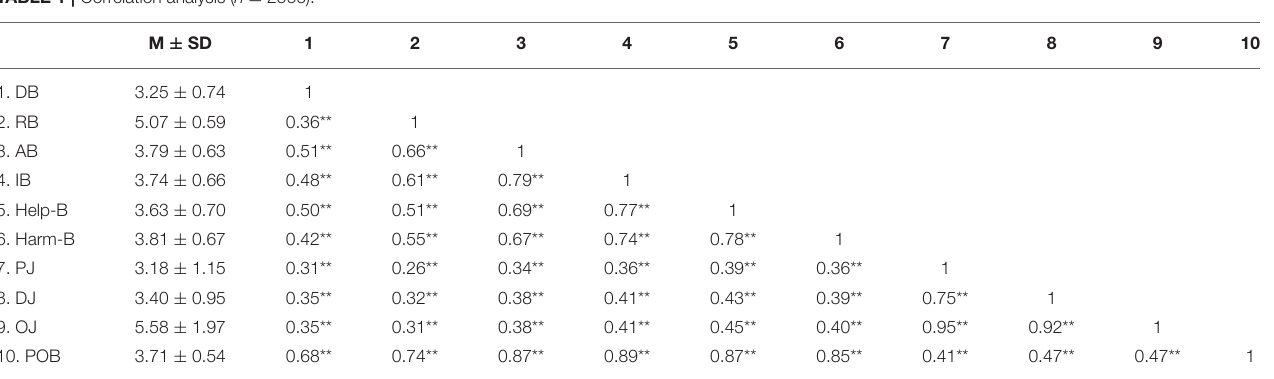
TABLE 1 | Correlation analysis ( n =